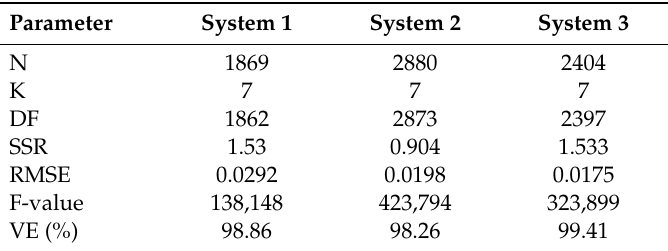
Table 3. Goodness-of-fit parameters for the kinetic model for acetone (system 1), MEK or butanone